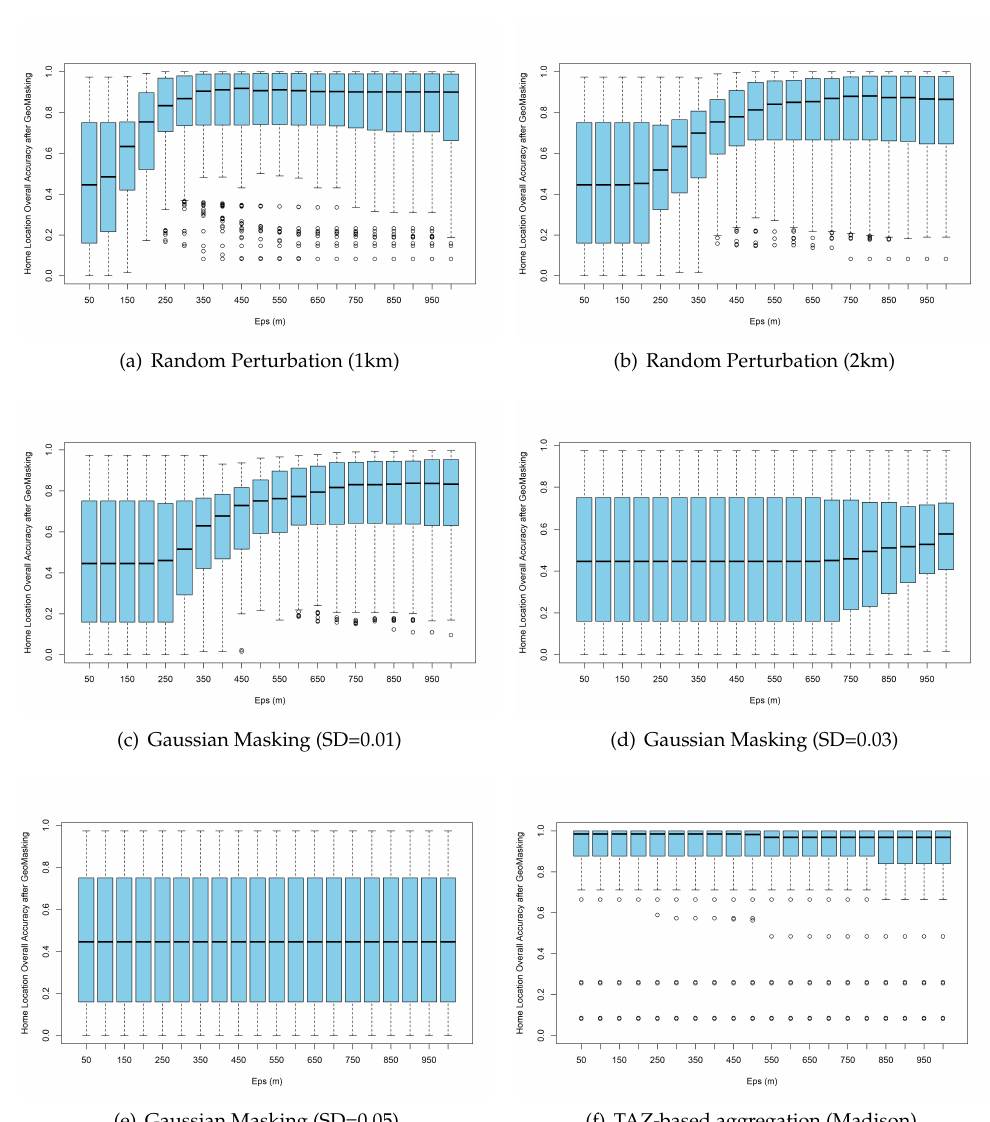
Figure 4: The boxplot of overall accuracy of home cluster detection with different DBSCAN parameters with random perturbation, Gaussian masking, and the TAZ-based